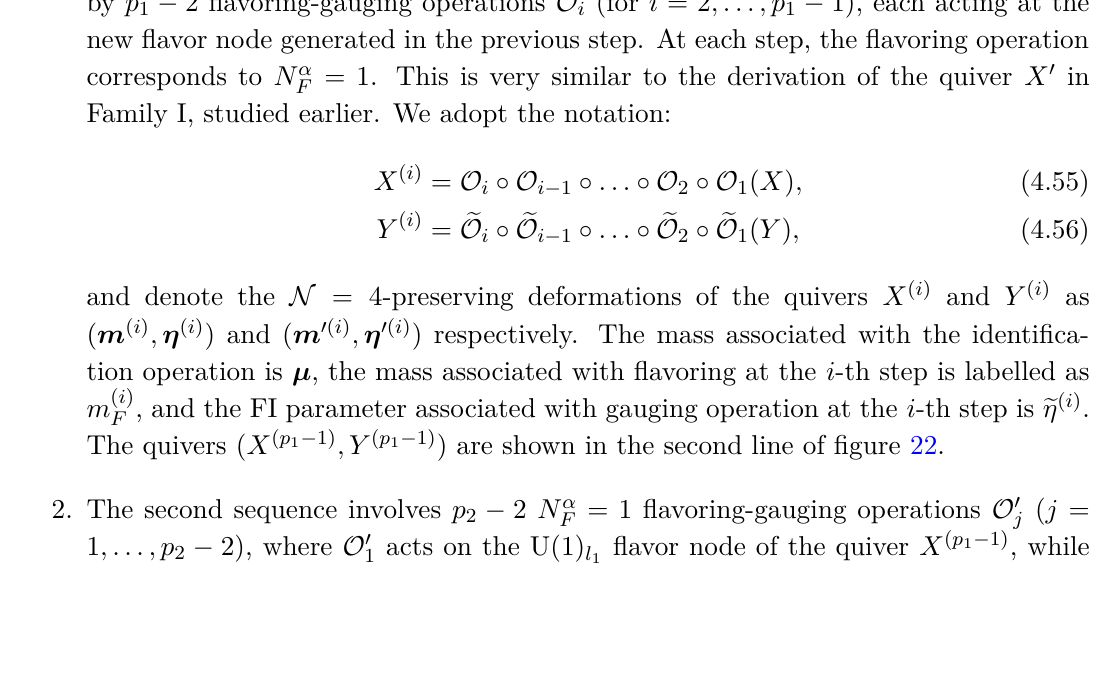
× U(1) × U(1) 1 l 1 ) , m , m , m 1 2 4 5